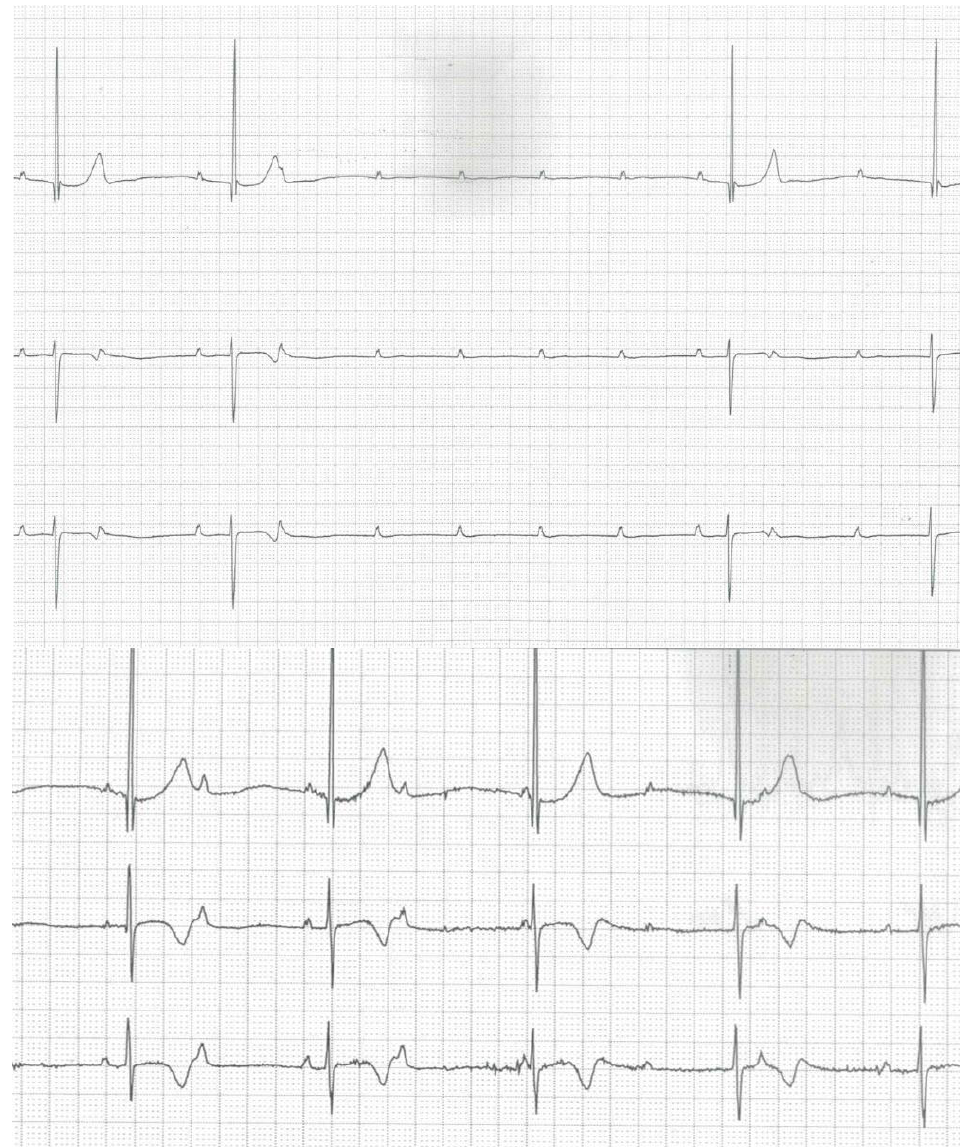
Figure 2. A 24 h Holter monitoring (8 years) showing a long nocturnal pause (upper line) and a daytime episode of III-degree atrio-ventricular block (lower line).